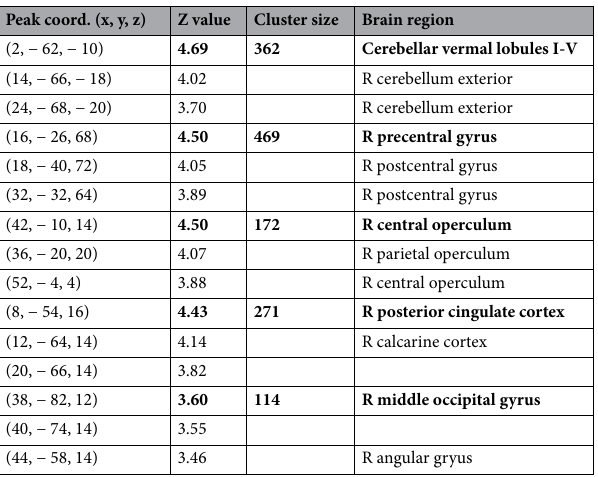
Table 5. Maxima of brain regions (MNI coordinates) for the increased neural activity for complex sentence processing (AVOS > SVAO) with longer hearing aid experience (i.e., years of hearing aid use); R = Right; Family-Wise Error corrected on the cluster level, threshold of p <